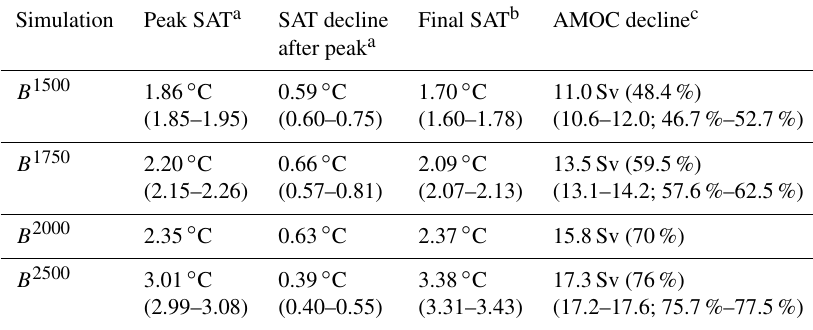
Table 2. SAT evolution and AMOC decline in the B simulations with 100 years of positive emissions and 300 years of zero emissions thereafter. Values are ensemble means (except for B 2000 ), and the ranges given are minimum and maximum values for individual ensemble